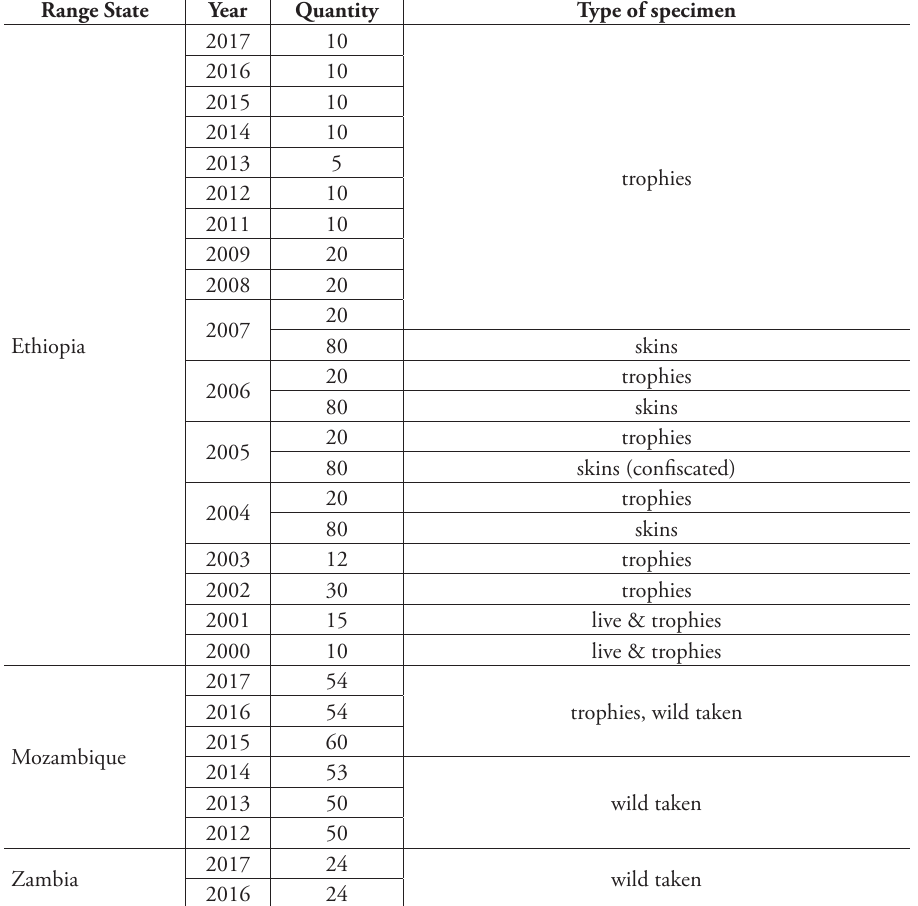
Table 6. Unilaterally-set quotas for the export of Panthera leo specimens. Data from http://www.cites.